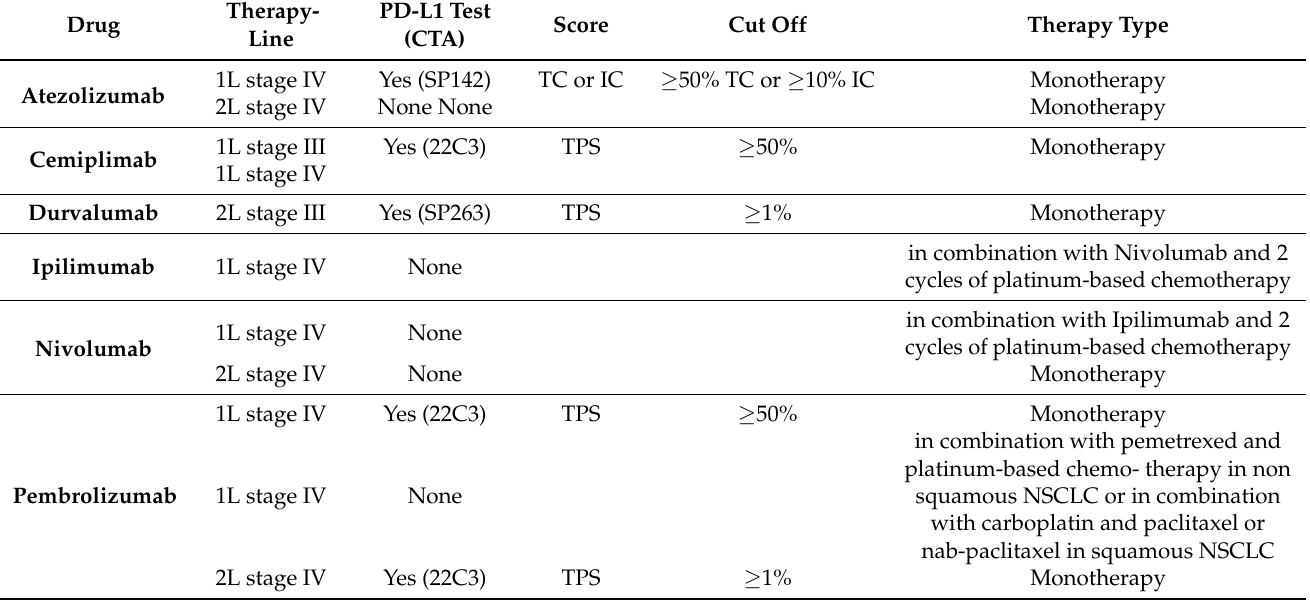
Table 1. Immunotherapy relevant to